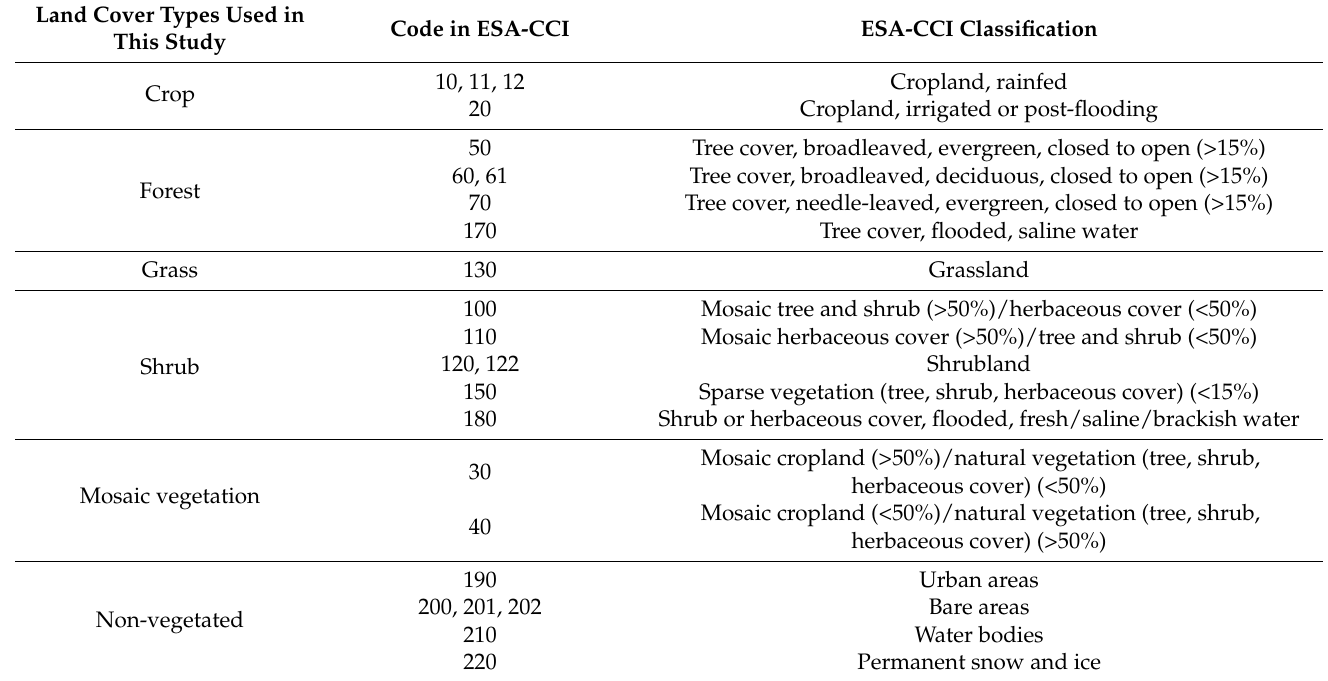
Table 1. Land cover reclassification in this study based on ESA-CCI